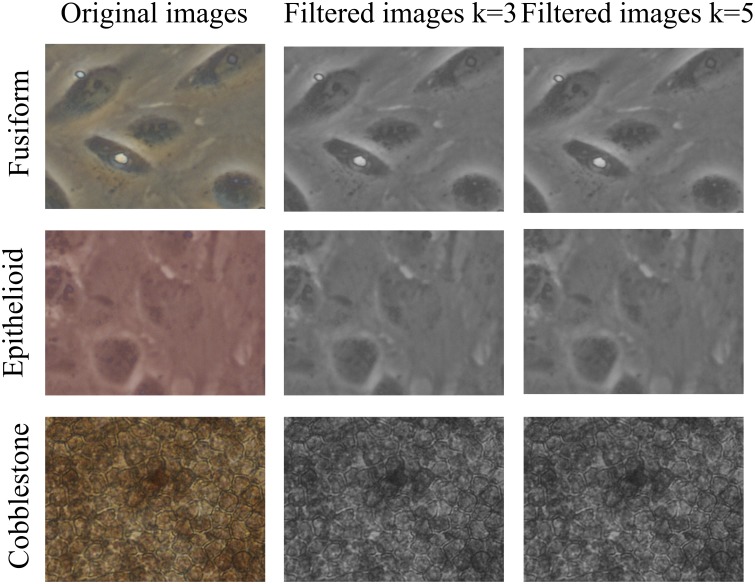
Preprocessing by MRS.Rows represent the three classes fusiform, epithelioid and cobblestone. Left: original image; center: image filtered by a lowpass filter k = 3; right: image filtered by a lowpass filter k = 5.